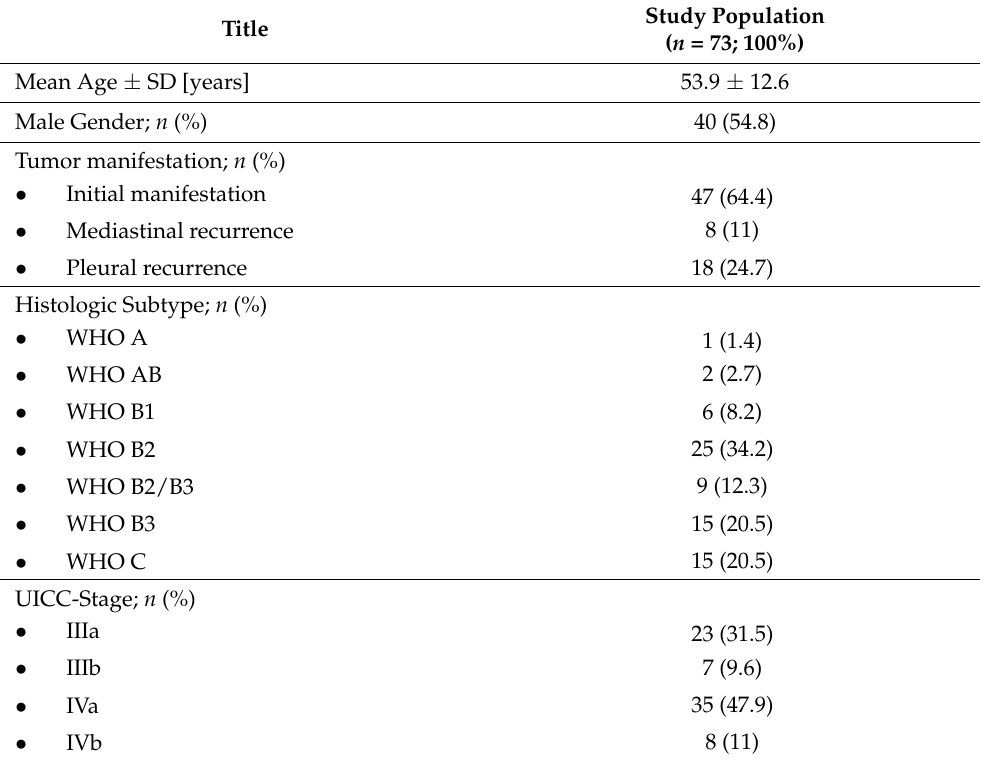
Table 1. Patients’ characteristics.